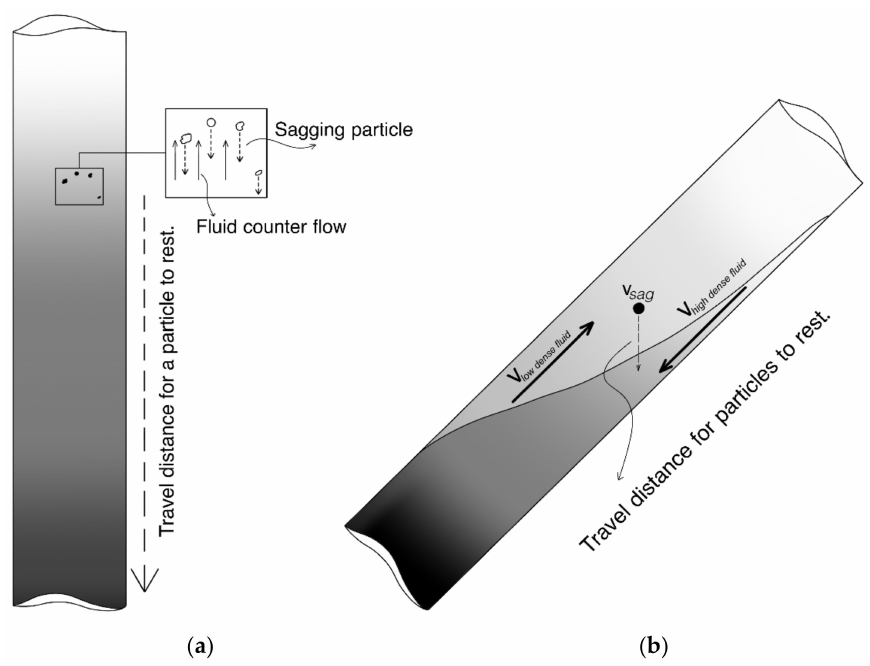
Figure 1. Settling in a well. ( a ) Settling in a vertical section. ( b ) Boycott